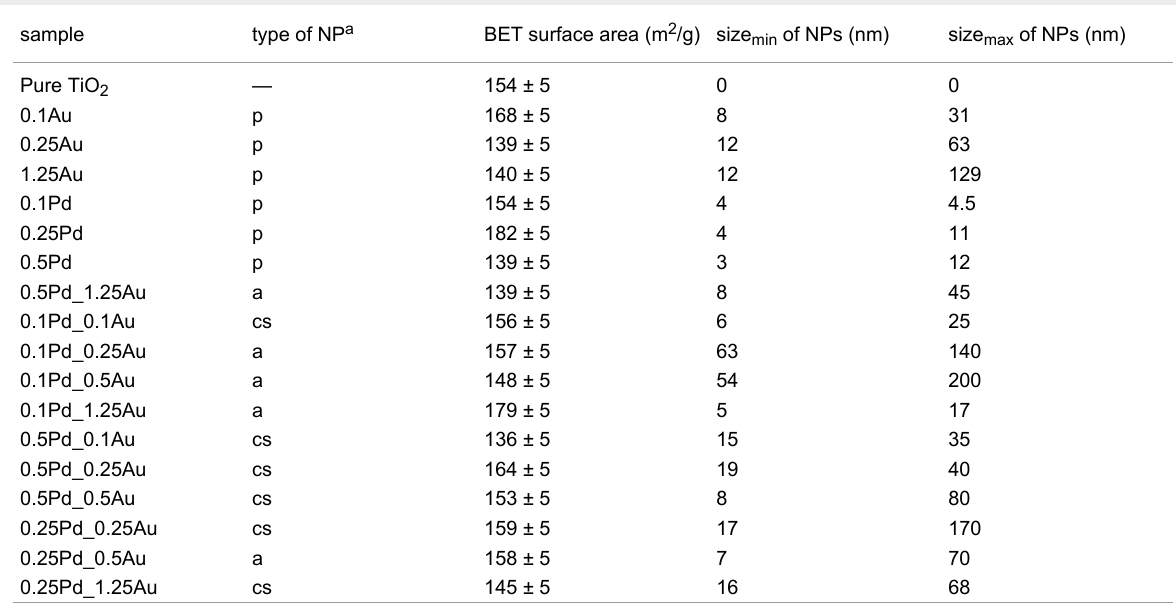
Table 2: Summary data of developed